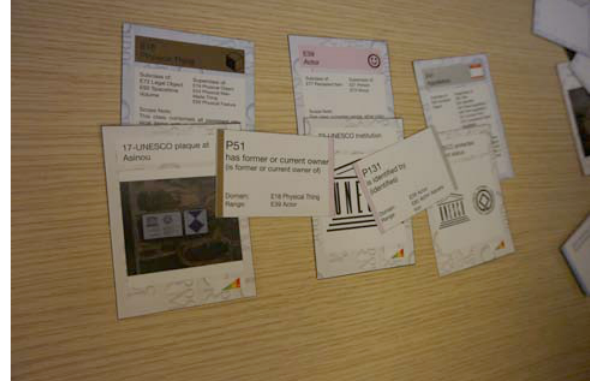
Figure 6. Example of Instance Cards mapped with CRM Cards According the answers from the questionnaire, reaction from the learning groups was overall highly positive toward the notion of appropriating CIDOC CRM through an interactive game process. The context of team-work allowed the players